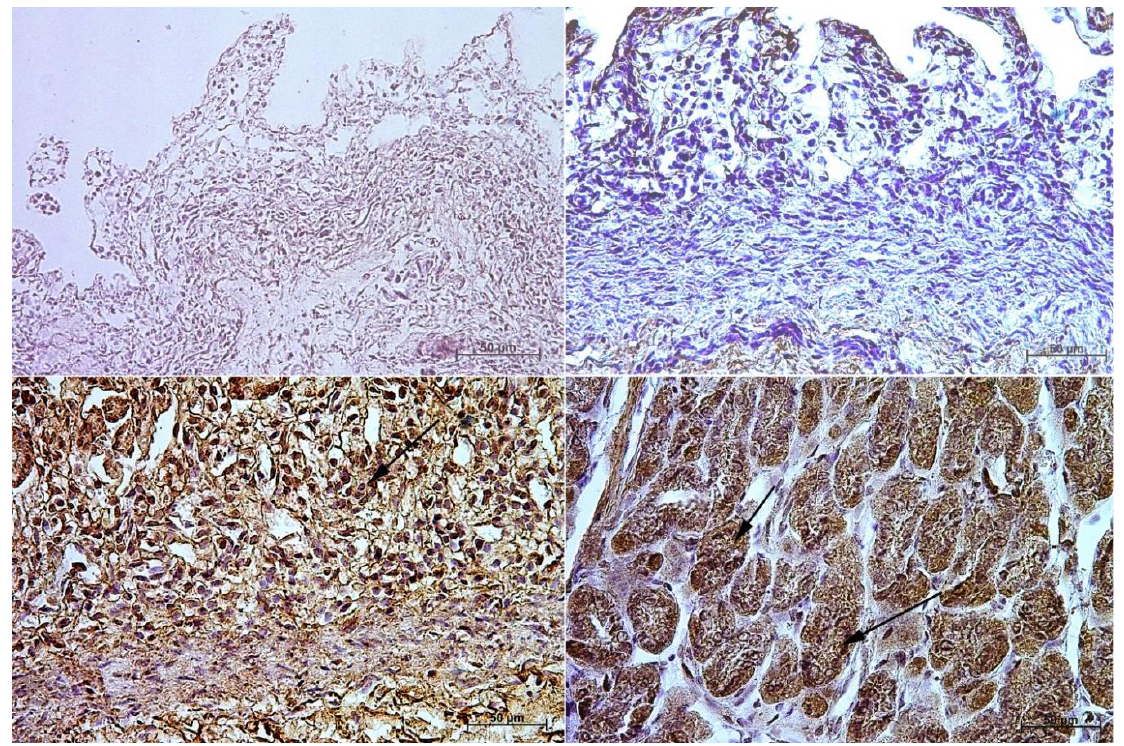
Figure 7. Immunoreactivity of anti-secretin receptor antibody in the fundic mucosa, 40×. ( A ) — the first age group, ( B ) — the second age group, ( C ) — the third age group, ( D ) — adult reference group. The arrow indicates positive immunohistochemical reaction.